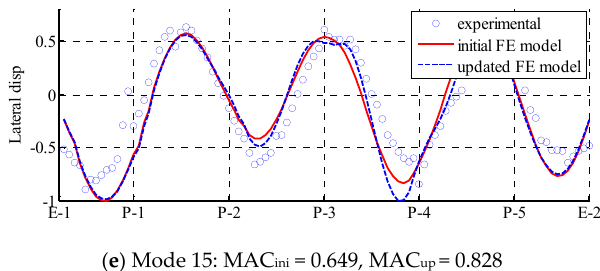
Figure 8. Higher modes that can only be identified from combined free–ambient vibration: comparison of mode shapes among experimental values (dot), initial FE model (solid line), and updated FE model (dash line).